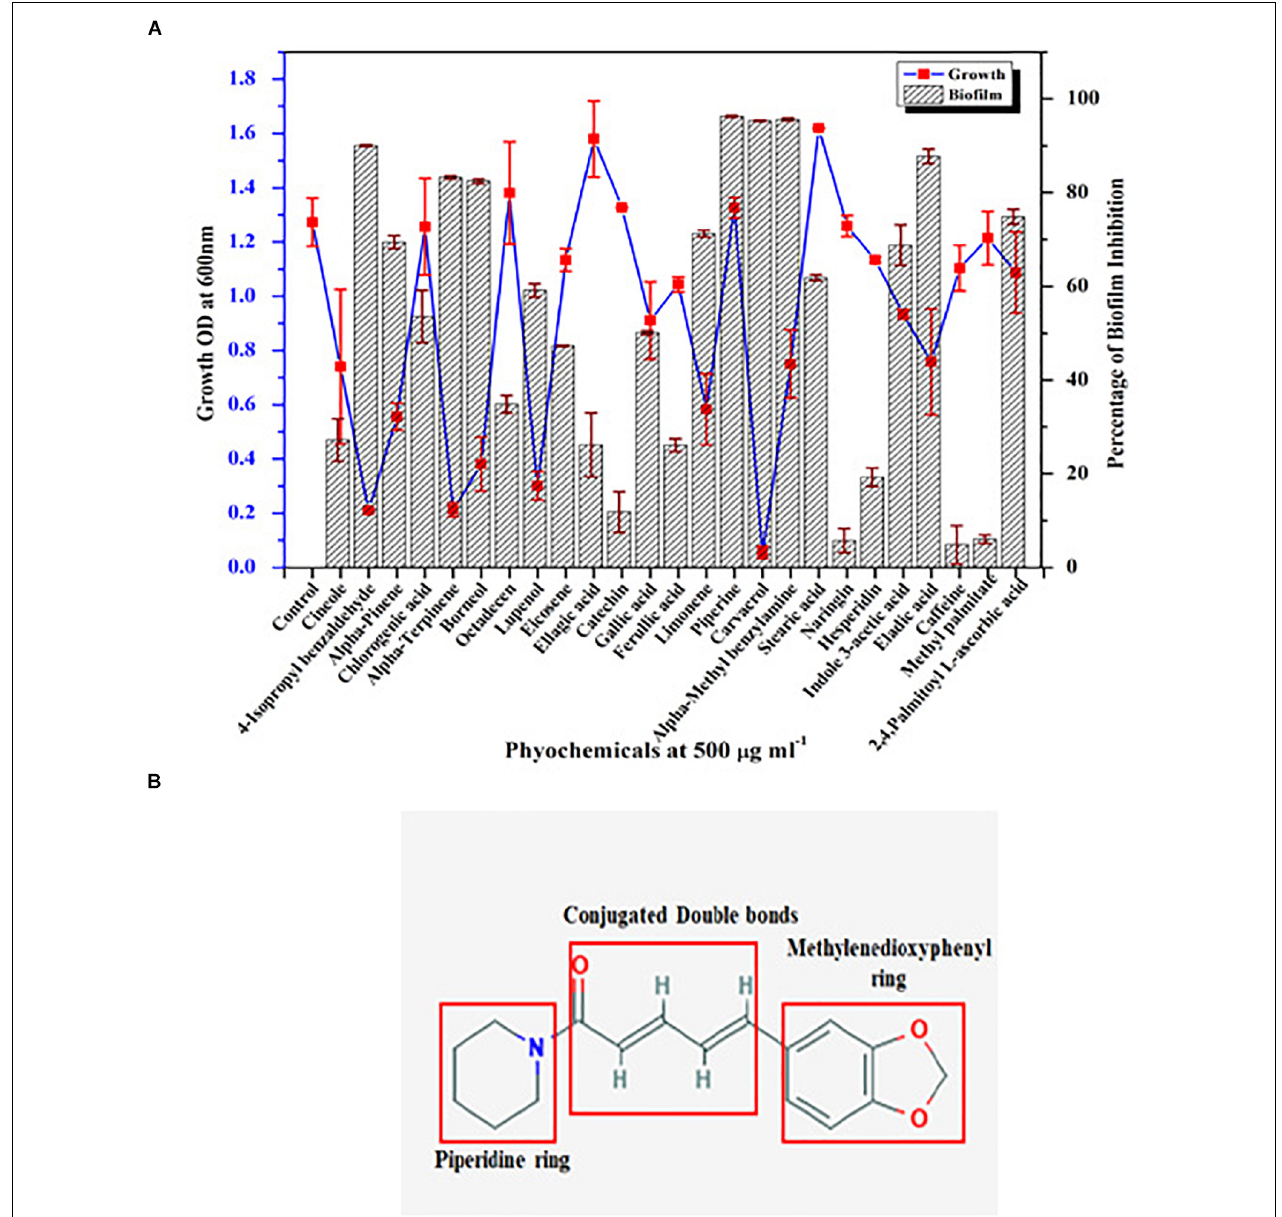
FIGURE 1 | Screening of phytochemical with potential antibiofilm activity against C. albicans . (A) Screening of various phytochemicals for antibiofilm activity against C. albicans through assessment of growth and biofilm inhibitory efficiency. Error bars represent standard deviations from the mean ( n = 3). (B) Chemical structure of piperine, the potential antibiofilm molecule found through screening of various phytochemicals. The three major components in the chemical structure of piperine were boxed within red colored square viz . piperidine ring, conjugated double bonds, and methylenedioxyphenyl